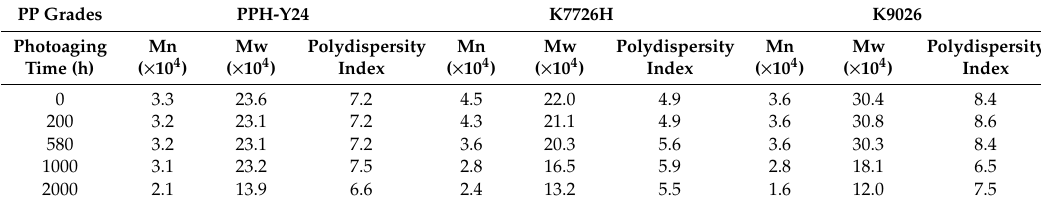
Figure 6. Gel Permeation Chromatography (GPC) curves ( a – c ) and molecular weight retentions ( d ) of PP resins with various photo degradation exposure time. (( a ), PPH-Y24; ( b ), K7726H; ( c ), K9026). Table 2. The molecular weights Mw and Mn and the polydispersity index for all PP resins.